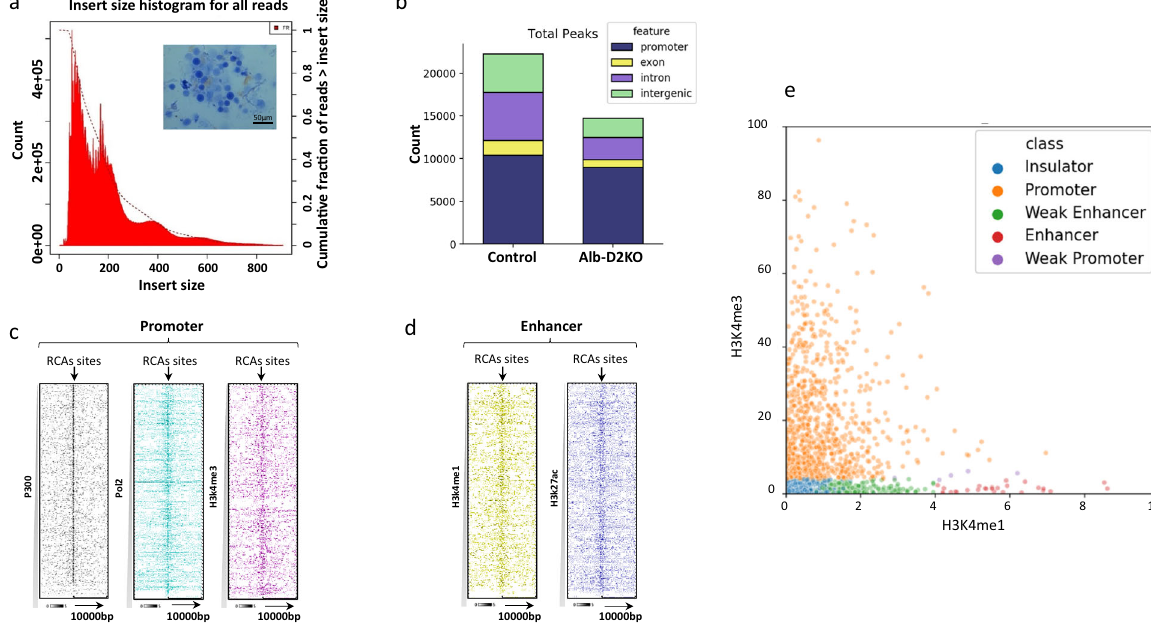
Fig. 2 Reduced chromatin accessibility (RCA) in the ALB-D2KO mouse liver nuclei. a the inset contains a representative image of isolated liver nuclei (40x) before adding the transposase enzyme; the graph indicates the lengths of the fragments sequenced within a representative ATAC-seq library; insert size in bp; the fi rst sharp peak (~100 bp) re fl ects areas of open chromatin, which is followed by 4 peaks of mono (~200 bp) or multinucleosomes of compact chromatin ( n = 4/group); the picture in the inset is representative of 14 independent nuclei extractions; the graph is representative of two independent library buildouts; b genomic distribution of peaks obtained in ATAC-Seq data; eight samples were studied with no further replication; c heat- maps prepared as in Fig. 1b, except that the x -axis contains the RCA peak coordinates at the center + / − 10,000bp and the y -axis contains the coordinates for P300, Pol2 and H3k4me3; d same as c , except that the y -axis contains the coordinates for H3k4me1 and H3k27ac; e classi fi cation of RCAs according to the relative intensities of H3K4me1 and H3K4me3 ChIP-seq peaks: promoter-RCAs, weak promoter-RCAs, enhancer-RCAs, weak enhancer-RCAs, and insulator-RCAs; each dot represents one RCA